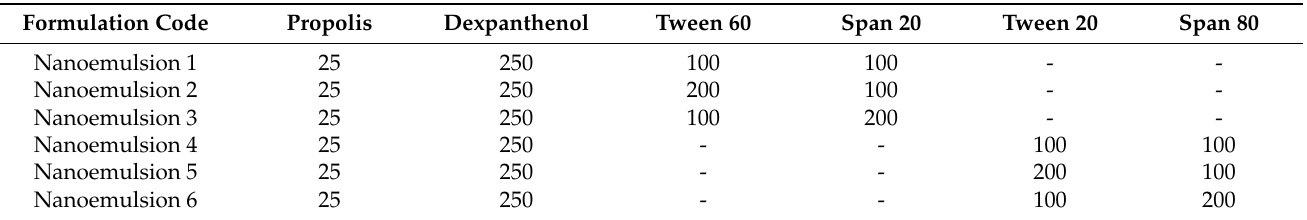
Table 1. Composition of propolis and dexpanthenol-loaded nanoemulsions (mg).